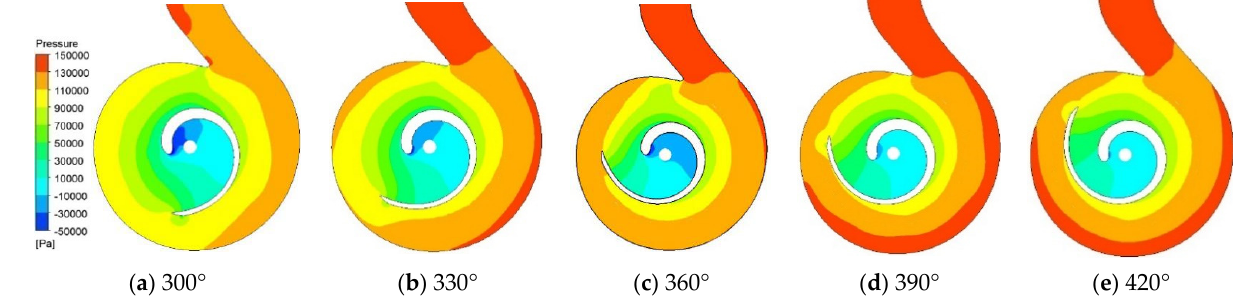
Figure 17. Pressure distribution in the pump under designed flow rate conditions.